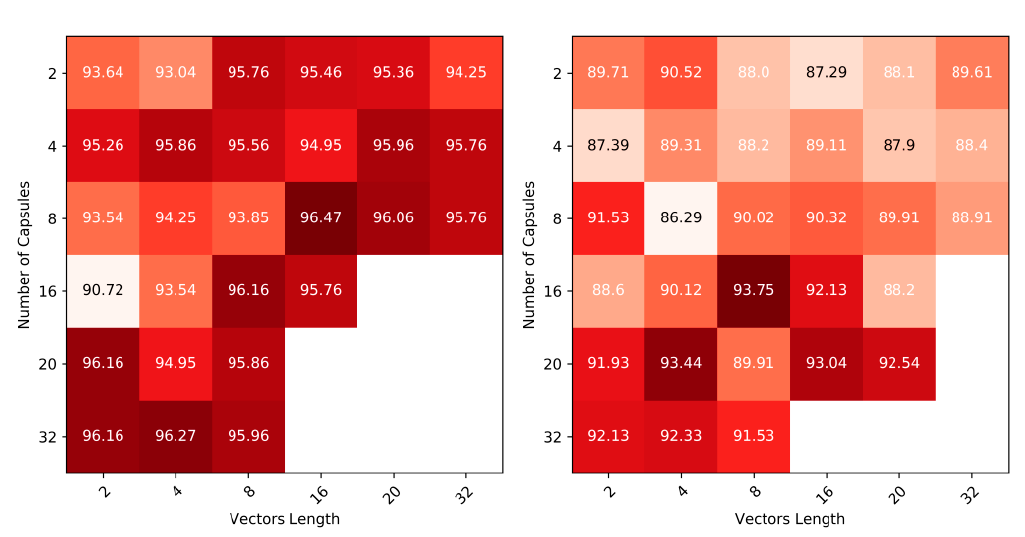
Figure 3. Number of Caps in the hidden layer versus the length of their output vectors: Left: Car dataset, Right: Solar Panel dataset.